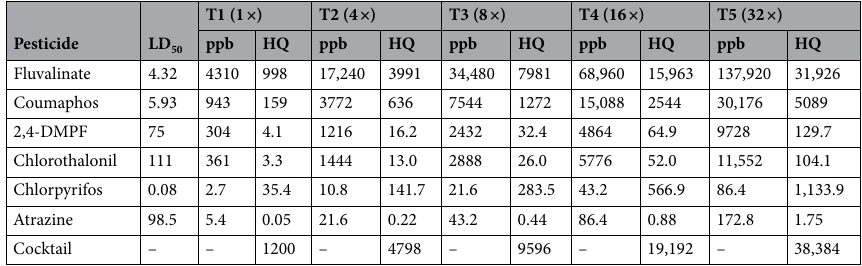
Table 1. Applications of each pesticide in terms of hazard quotients (HQ) and parts per billion (ppb). Each treatment is expressed as a multiplication of the corresponding amounts quantified from commercially surveyed wax, where x = the median 10 . LD 50 values are for workers and were sourced from Traynor et al. 2016 10 .